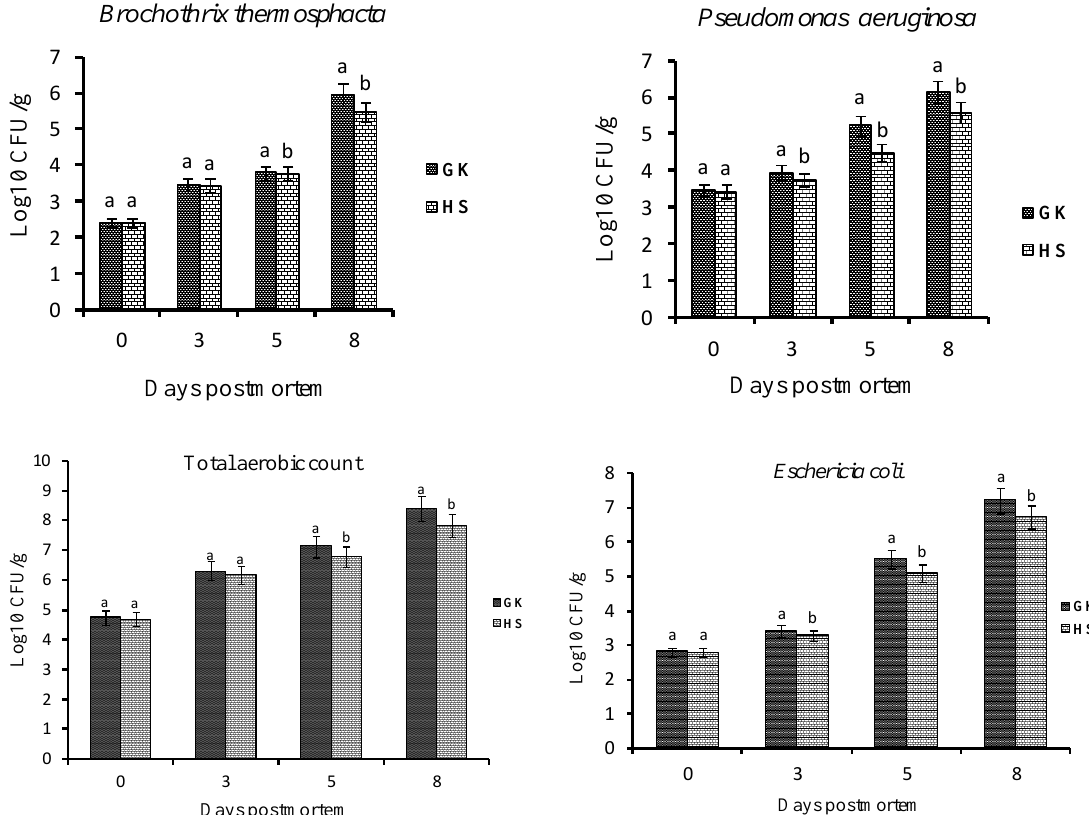
Figure 3. Meat microbiological quality of New Zealand white rabbits subjected to halal slaughter without stunning and gas stun-killing. HS: Halal slaughter without stunning; GK: gas stun-killing. ab Means with different letters differ significantly at